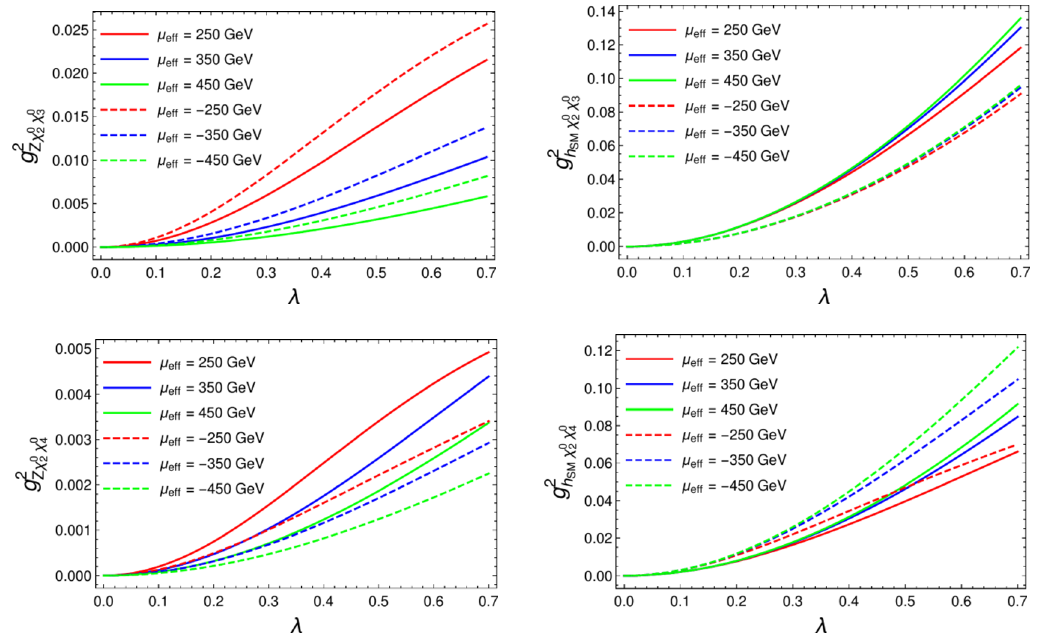
Figure 14 . Variations of the couplings g 2 and g 2 (bottom, right) with respect to ‘ λ ’ for various values of µ h SM χ 0 2 χ 0 4 and (C.8). χ 0 is singlino-dominated while χ 0 2 100 GeV while tan β = 10 . See text for